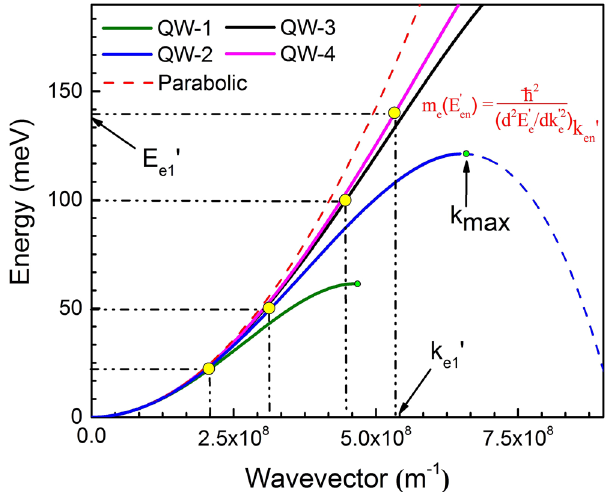
Figure 5. Dispersion curves of conduction band electron for the four QWs. Parabolic dispersion curve of bulk GaAs is also shown (red dashed line). It is clearly observed that the induced non-parabolicity in bands becomes dominant at higher ′ k value. The yellow dot signs in dispersion curve indicates ground state ( ′ E e in QWs. Green dot sign signifies the maximum state up to which the dispersion curve is